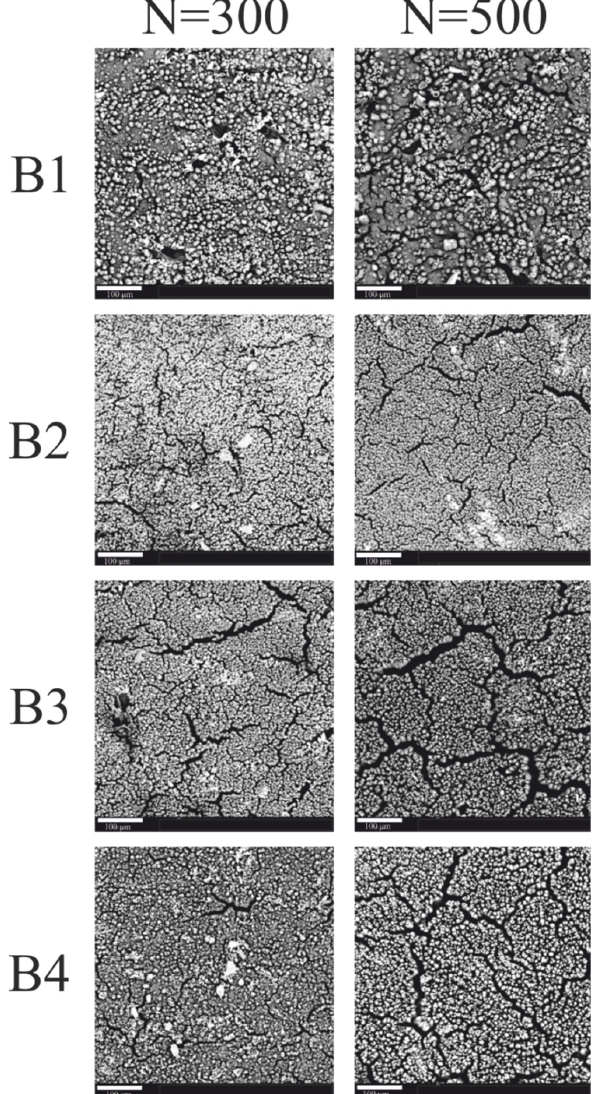
Figure 7. SEM images of metallized B1–B4coatings (scale—100 μ m).